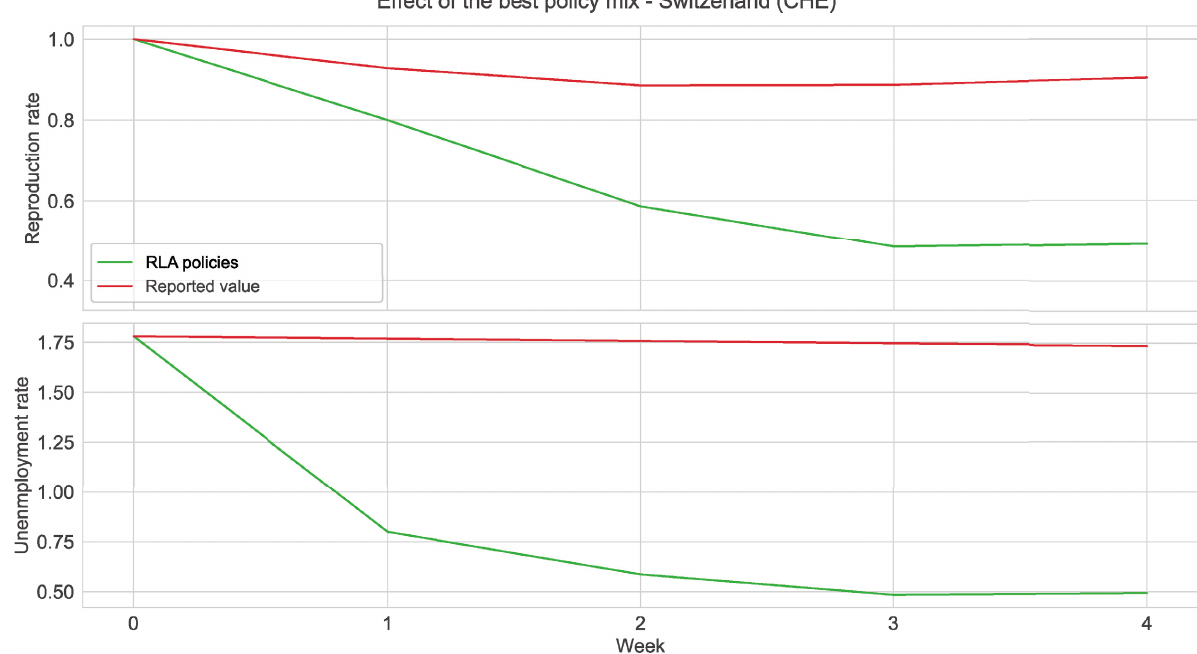
Fig 7. Effect of the best policy mix on Switzerland. Effect of the best policy combination on the R E and UER (12/04/2021–09/05/2021). The green line refers to the best policies predicted by the RLA. The red line is the true, measured, value.